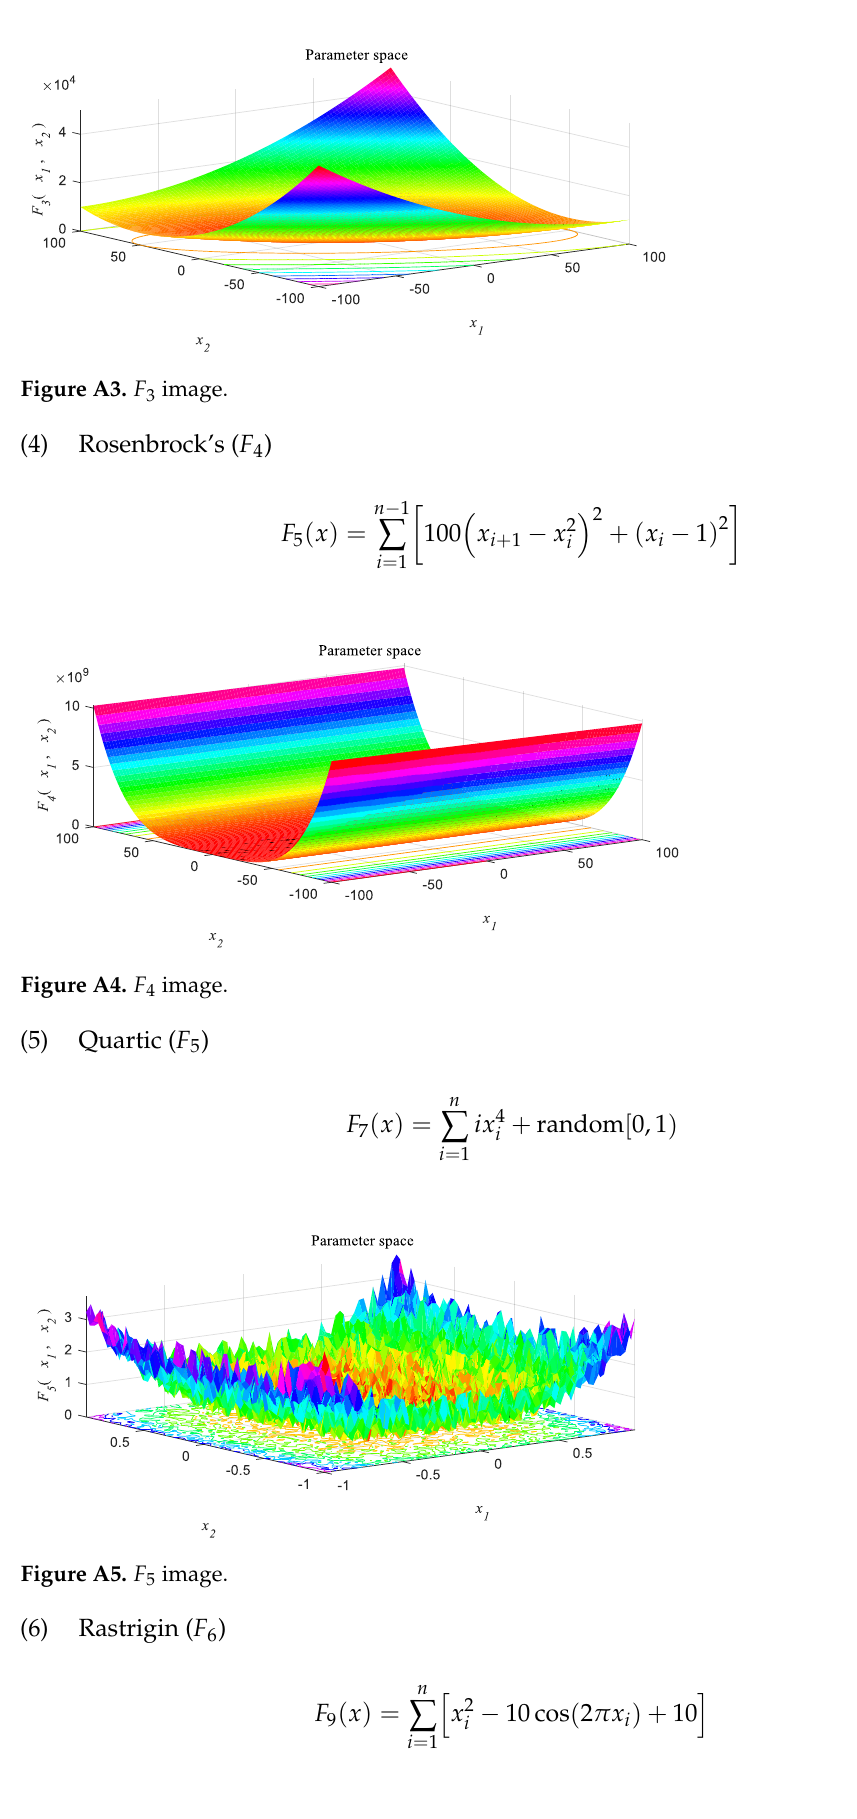
Figure A3. F 3 image.